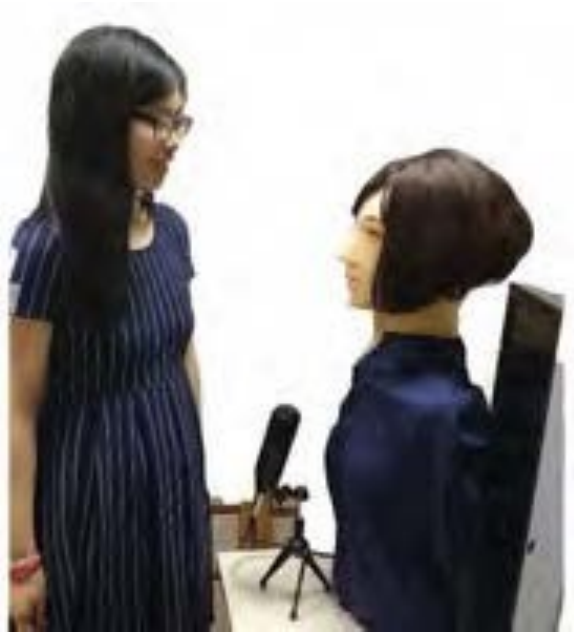
Figure 3: Establishment of ’gaze’ from [18].